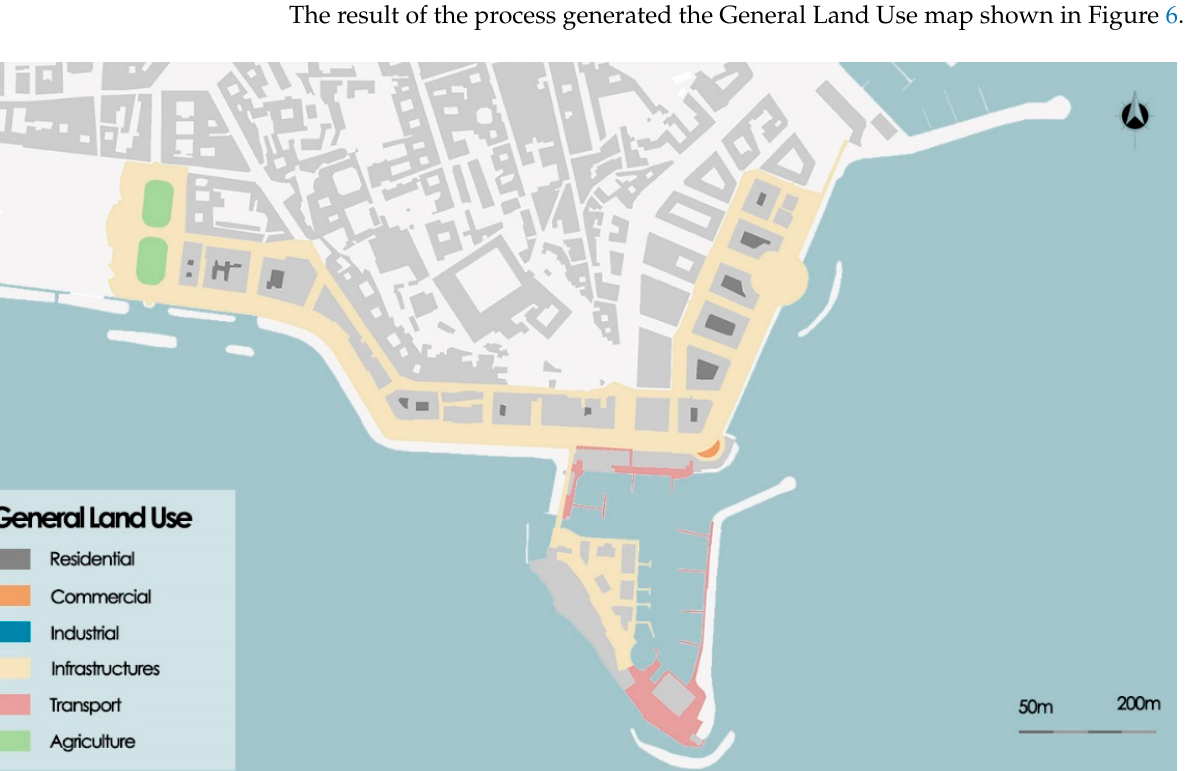
The result of the process generated the General Land Use map shown in Figure 6.